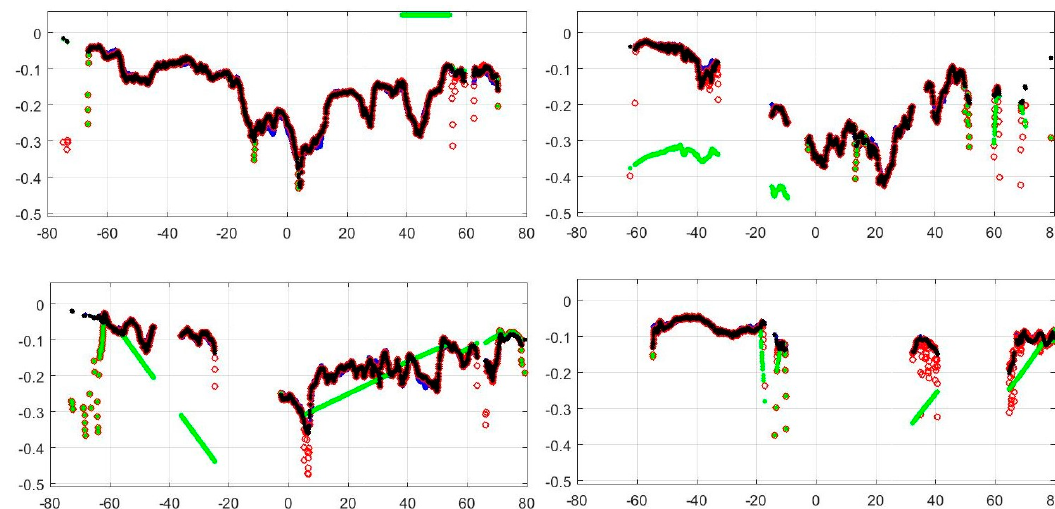
Figure 22. From top to bottom and left to right: WTC (in metres) for S3A cycle 06 passes 041, 646, 660, and 670, as a function of latitude (degrees). Shown are: ECMWF Operational (blue), MWR (red), GPD2 (black), and composite (green) WTC.